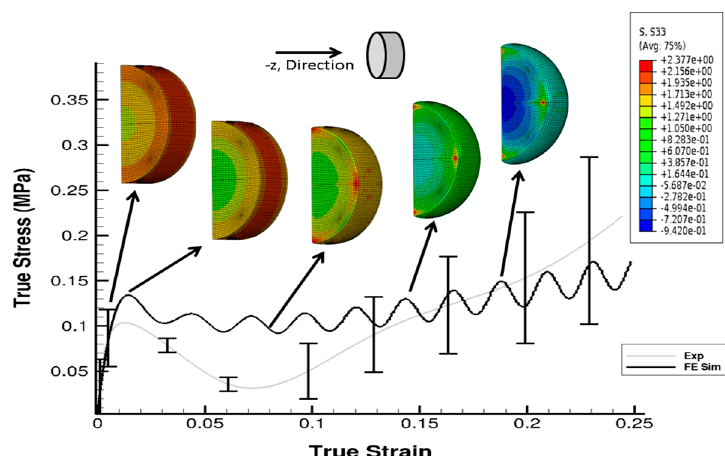
Figure 6. Contour plot ( σ 33 ) with comparison of σ 33 from the experiment and the FE simulation at 550 s − 1 . Sample is a solid cylindrical disk, and σ 33 data from FE simulation were processed in DAVID Viscoelastic Software.